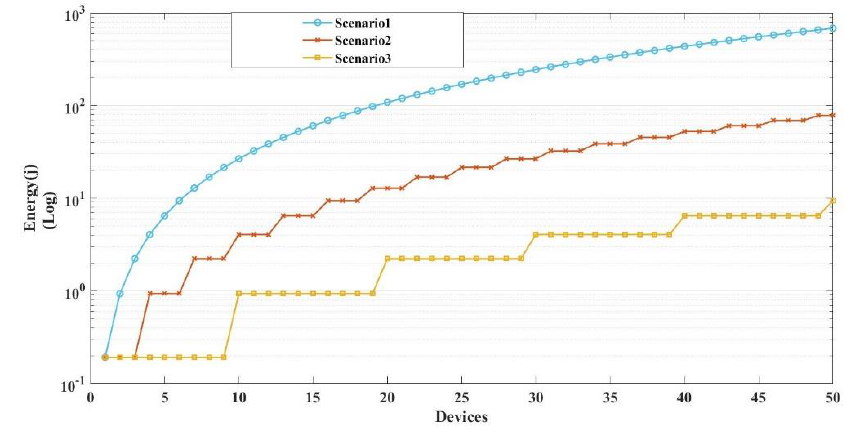
Figure 5. Energy consumption for the 50 devices—where the distance is 200 m.